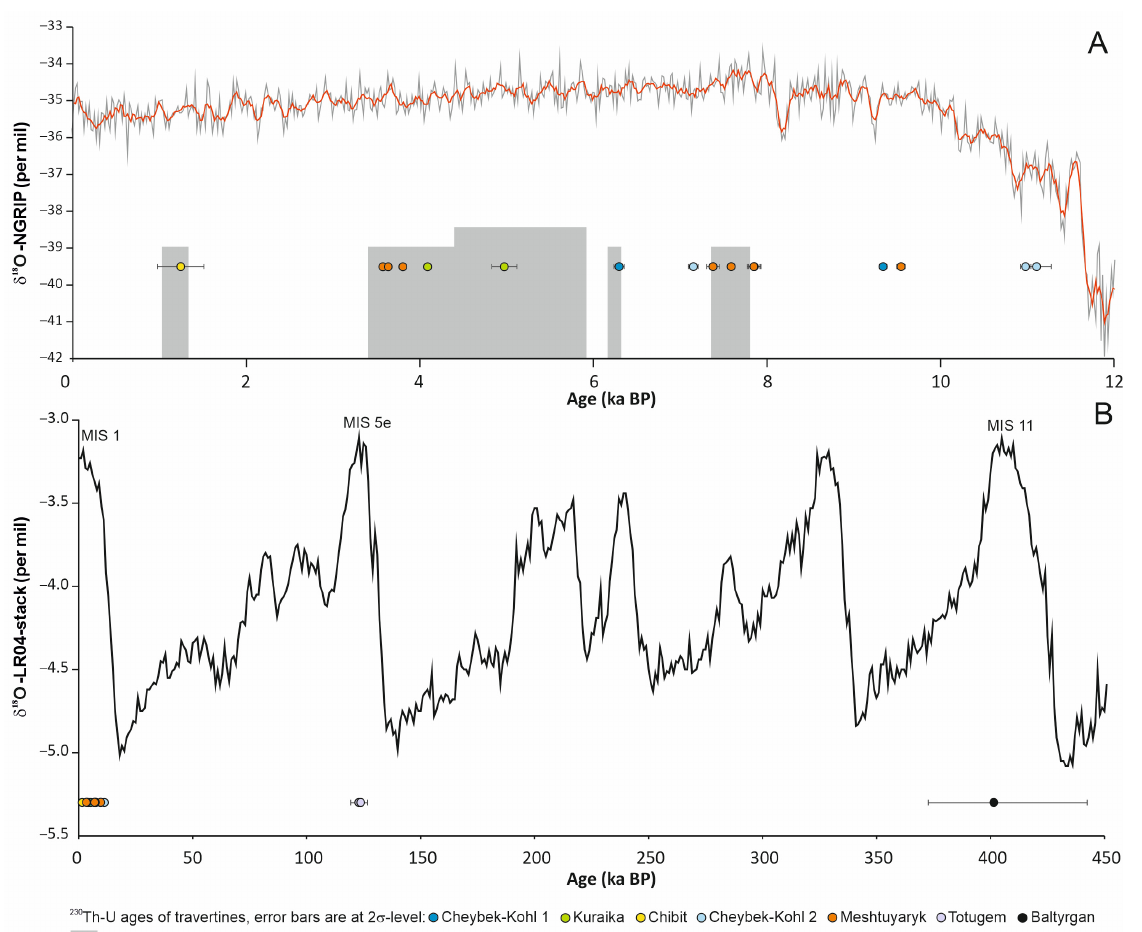
Figure 17. Age dates of the travertines (U-Th) and large paleoearthquakes ( 14 C) in the south-eastern Gorny Altai shown in the context of the paleoclimate proxy records: ( A ) North Greenland Ice Core Project (NGRIP) δ 18 O [132,133]; grey line—complete data set; red line—5-point moving average. ( B ) LR04-stack δ 18 O [134].